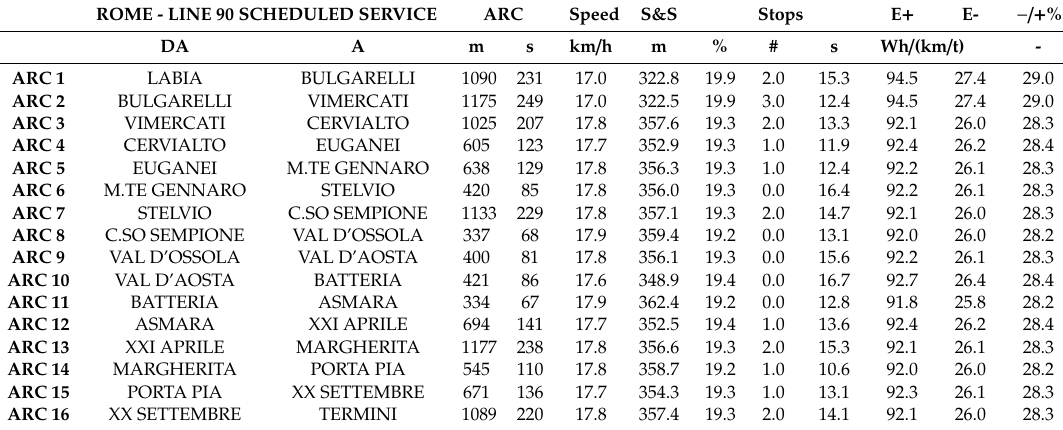
Table 2. Scheduled Timetable of the “LINEA90” in